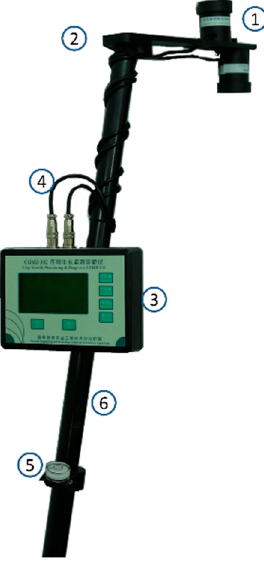
Figure 2. External view of the CGMD apparatus: 1 (cid:13) Multispectral sensor; 2 (cid:13) Sensor support; 3 (cid:13) Processor system; 4 (cid:13) Shielded cable; 5 (cid:13) Gradient measurement device; 6 (cid:13) Support bar.